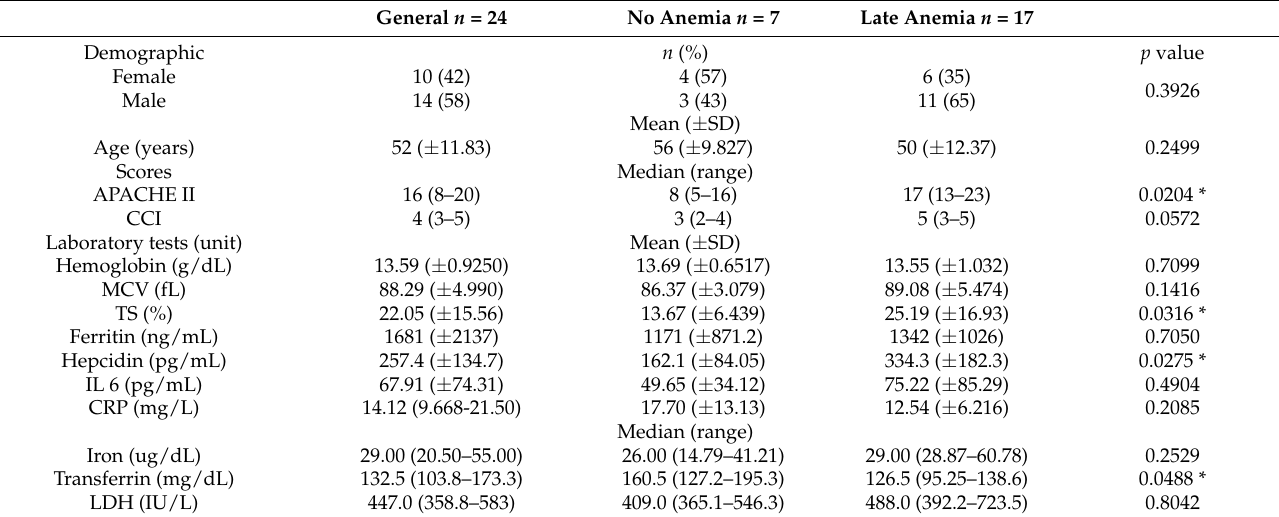
Table 3. Demographic, clinical and laboratory parameters of patients who developed anemia during ICU